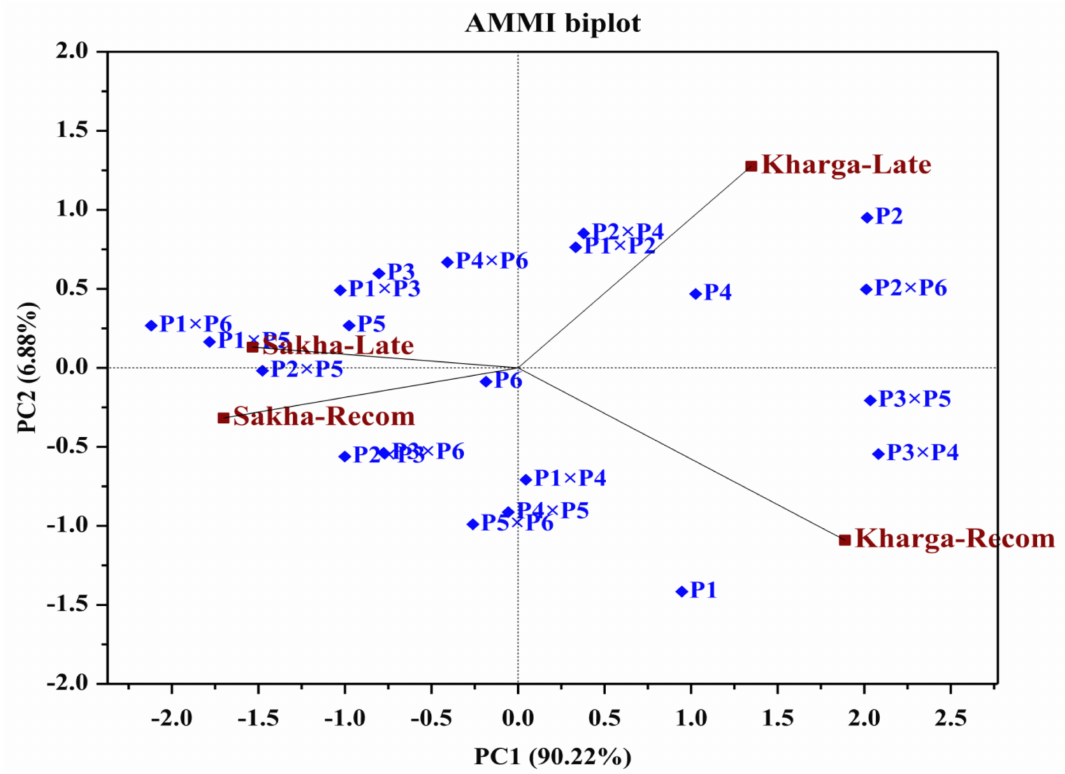
Figure 7. AMMI biplot for grain yield of six wheat genotypes and their fifteen F 1s were tested in four environments at Kafr El-Sheikh at El-Kharga under recommended sowing date and late